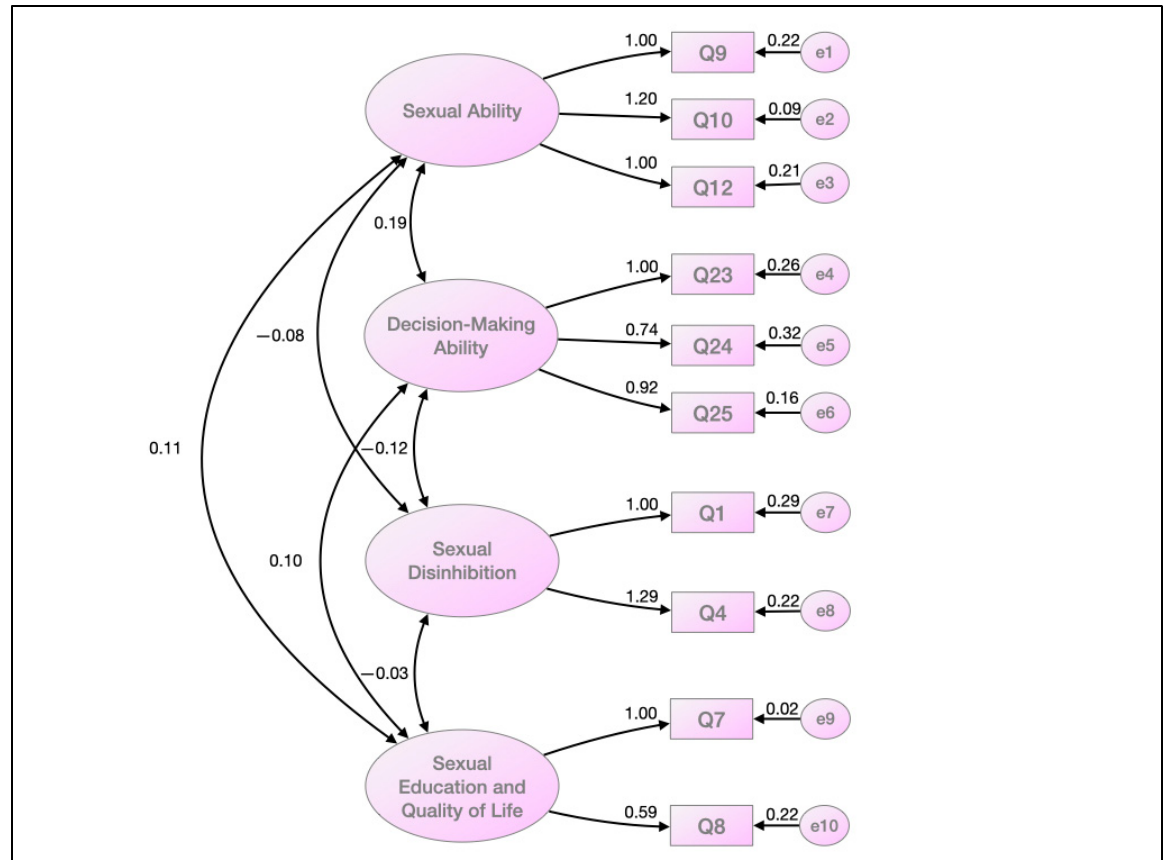
Figure 1. Internal measures of the construct. Confirmatory factor analysis.